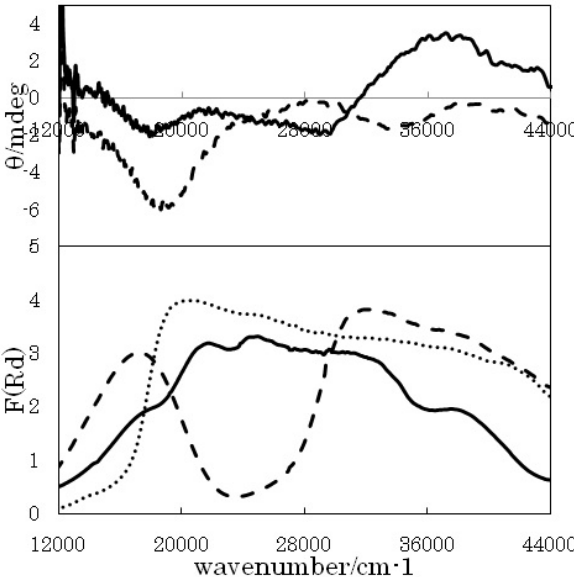
Figure 2. Solid state CD and diffuse reflectance electronic spectra for Cu-Cr-RR-dm (solid lines), the corresponding Cu-precursor (broken lines), and the Cr-precursor (dotted lines).